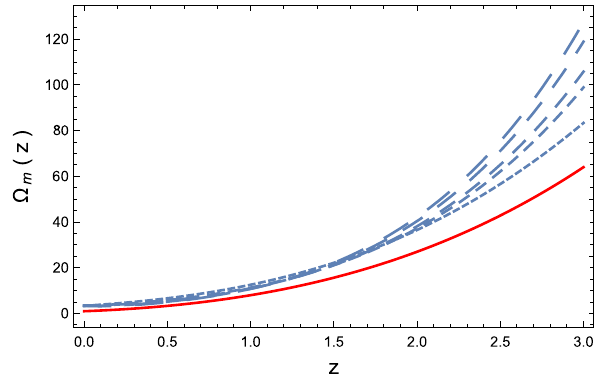
Fig. 6 Variationinthedensityparameterofthematter (cid:15) m asafunction of the redshift z in the Barthel–Kropina-FLRW dark energy model for different values of the parameter w of the dark energy equation of state: w = 1 . 45 (short dashed curve), w = 1 . 85 (dashed curve), w = 2 . 05 (longdashedcurve), w = 2 . 55(ultra-longdashedcurve),and w = 3 . 05 (ultra-ultra-long dashed curve), respectively. The red solid line repre- sents the prediction of the (cid:2) CDM model. The initial conditions used to numerically integrate the system of cosmological evolution equations are f ( 0 ) = 0 . 33, u ( 0 ) = 0 . 51, and h ( 0 ) = 1,